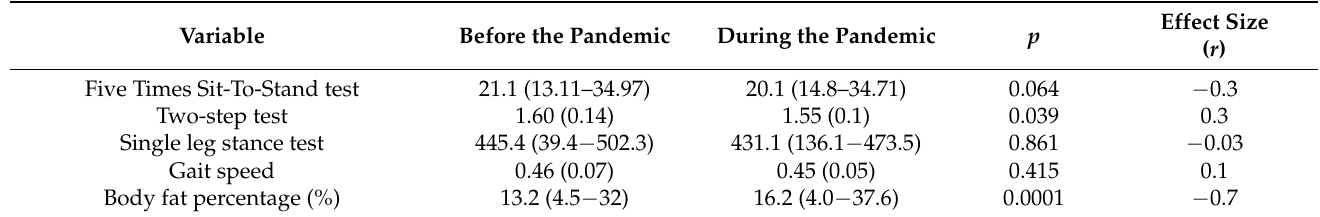
Table 2. Participants’ physical functions and body composition before and during the COVID-19 pandemic.